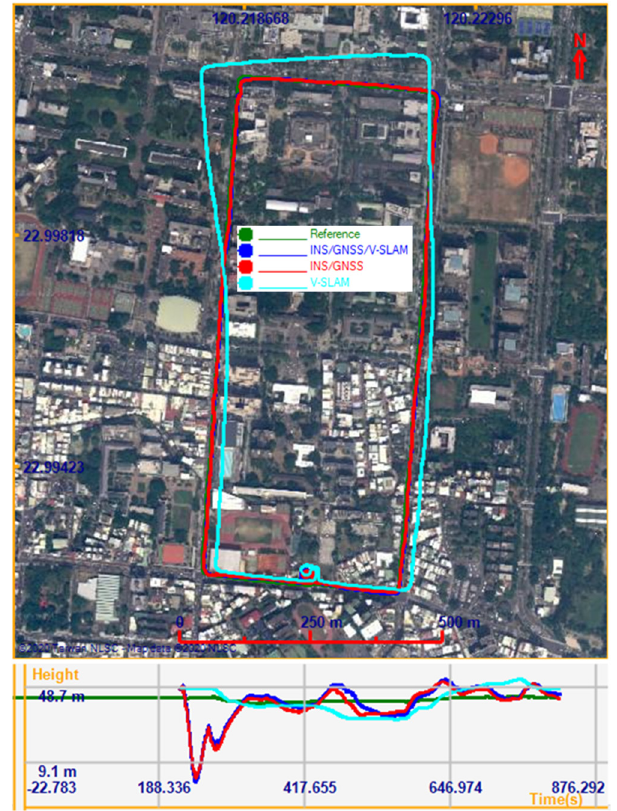
Figure 11. Trajectories of the various solutions in the first test.